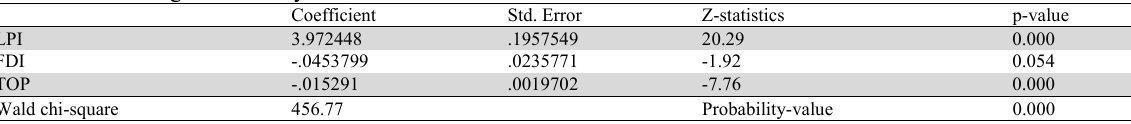
The results of the regression analysis